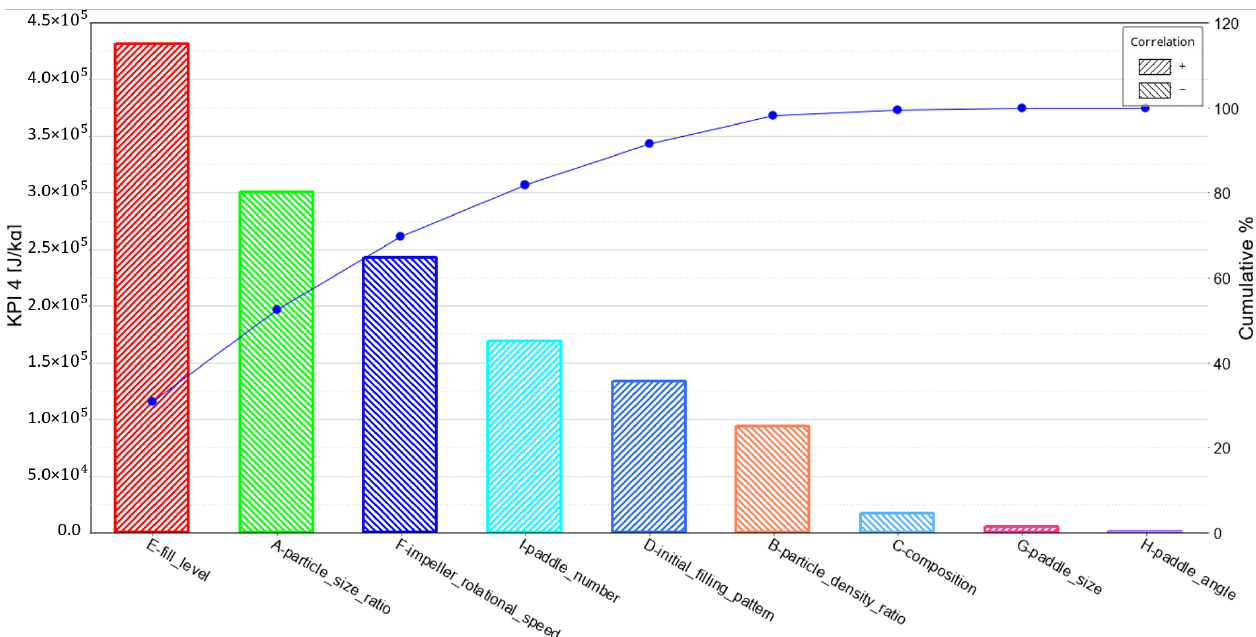
Figure 12. The Pareto plot for KPI 4 total energy consumption.